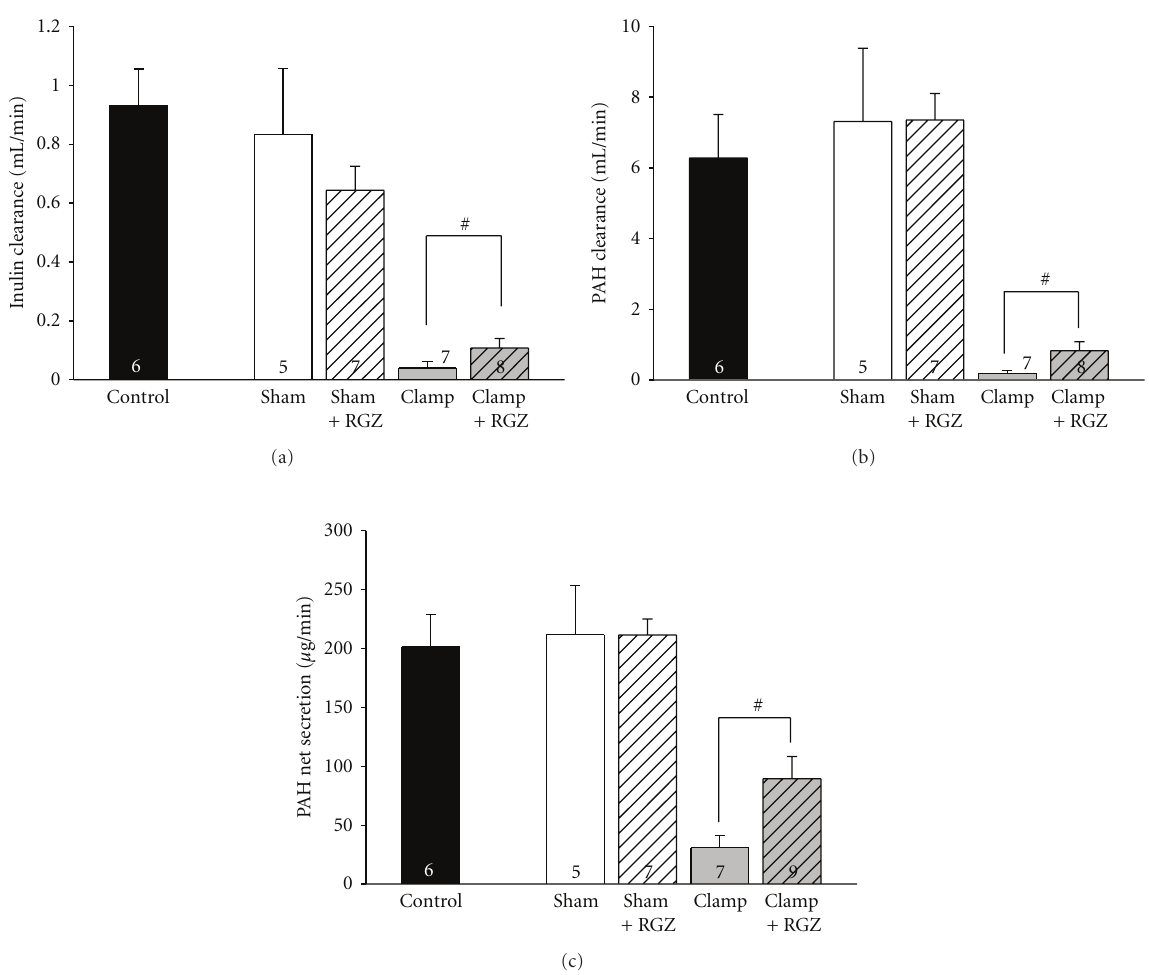
Figure 1: E ff ect of 5mg/kg rosiglitazone (RGZ) on parameters of renal function in Sprague-Dawley rats in renal I/R injury. After either a sham operation or a bilateral clamping of the renal arteries for 60min, rosiglitazone was applied i.p. or not, and parameters of renal function were determined 24 h afterwards. Parameters were additionally determined in untreated control rats. n as indicated. # Statistically significant di ff erence as indicated. (a) Renal clearance of inulin was determined as a measure of GFR as described in Section 2 (GFR = ( I U × V U ) / ( I P × t ), where I U is inulin concentration in urine, I P is inulin concentration in plasma, V U is urine volume, t is time of measurement, and GFR is glomerular filtration rate). (b) Renal clearance of PAH was determined as described in Section 2 (PAH clearance = (PAH U × V U ) / (PAH P × t ), where PAH U is PAH concentration in urine, PAH P is PAH concentration in plasma). (c) Renal net secretion of PAH (PNS) was determined as described in Section 2 { PNS = [(PAH U × V U ) /t ] − [GFR × PAH P ] }